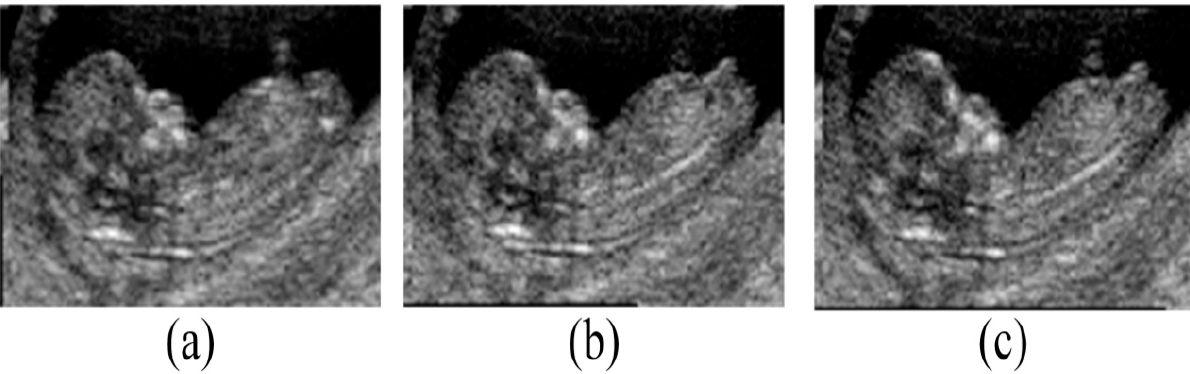
Figure 10. Midsagittal plane extraction using the ( a ) manual, ( b ) semi-automatic, and ( c ) automatic methods.